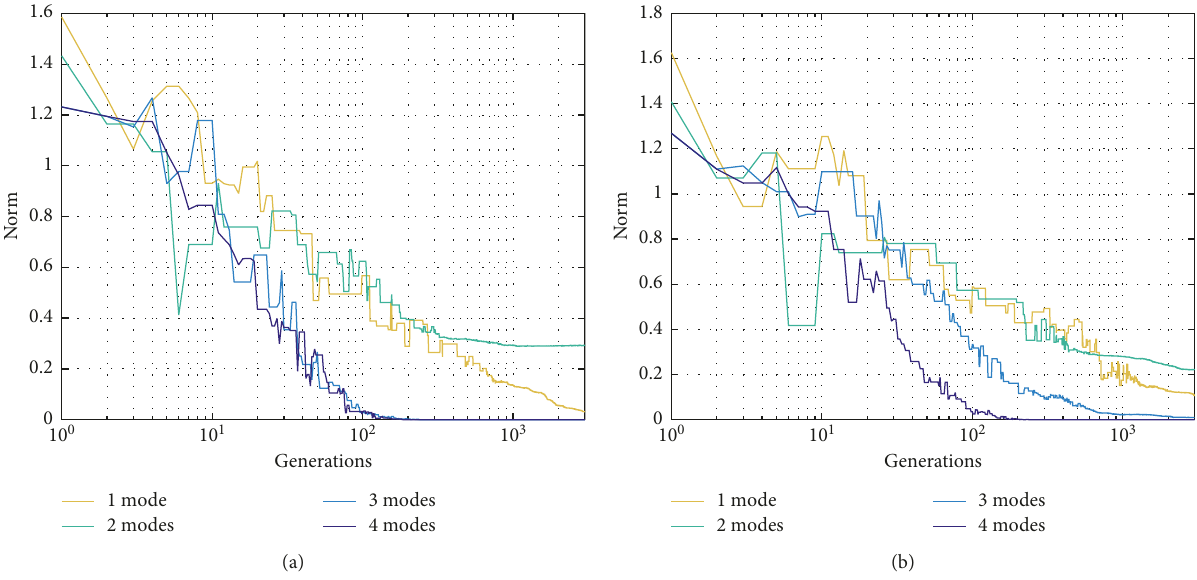
Figure 6: Beam example: norm values for the combined objective function, for different numbers of known eigenmodes, for damage scenarios 2 and 3 (no noise). (a) Scenario 2 and (b) scenario